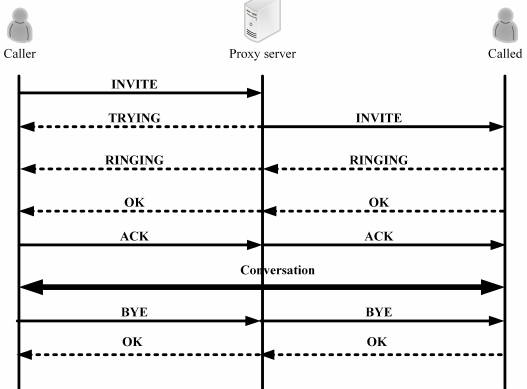
Figure 3. Session Initiation Protocol (SIP) call